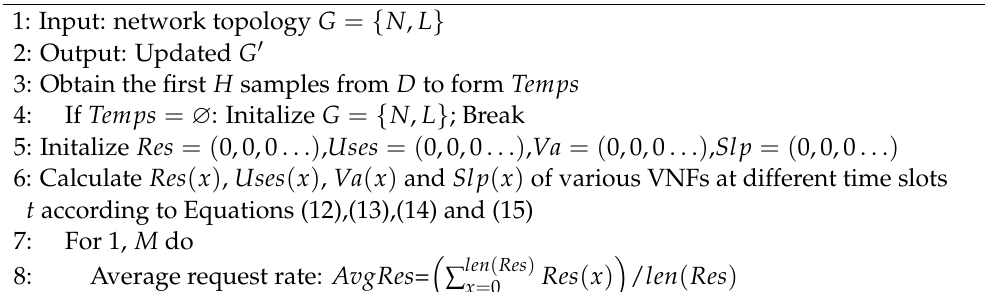
Algorithm 2: VNF re-orchestration